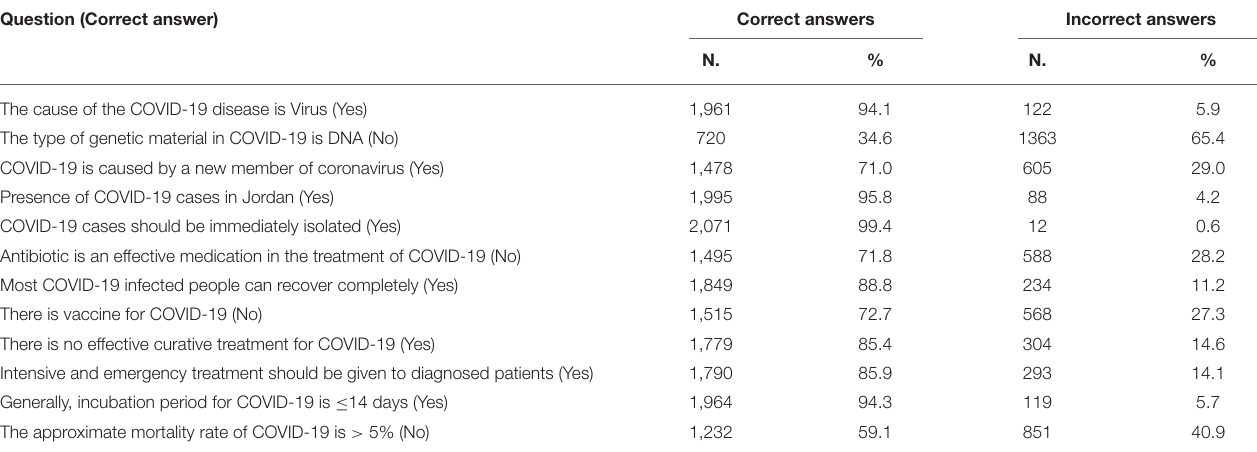
TABLE 2 | Responses about general knowledge of COVID-19 among University students in